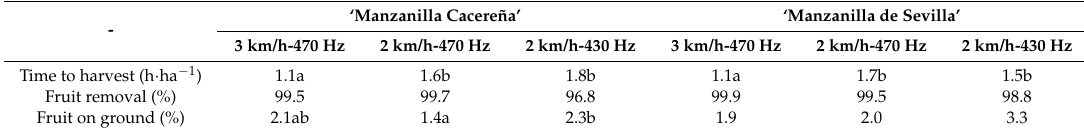
Table 3. Harvesting efficiency for each nominal travel speed and beating frequency.